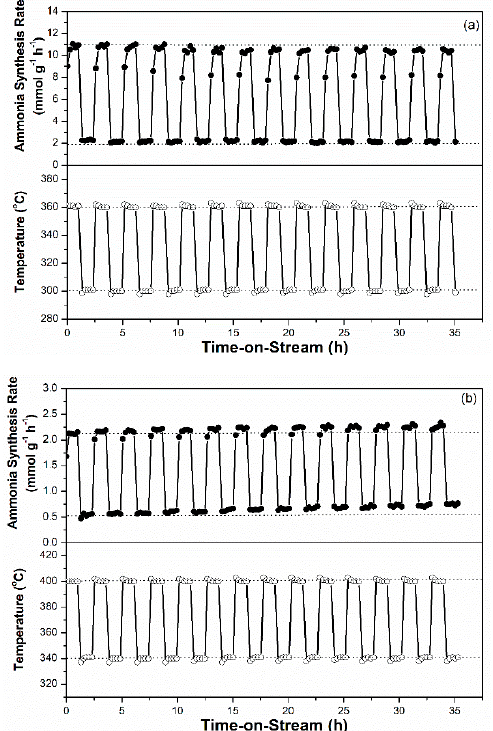
Figure 9. Rate of ammonia synthesis as a function of space velocity (SV) over the prepared Cs-Ru catalysts: ( a ) 2.5Cs-10Ru / MPC-18 and ( b ) 2.5Cs-10Ru / AC. catalysts: (a) 2.5Cs-10Ru/MPC-18 and (b) 2.5Cs-10Ru/AC.